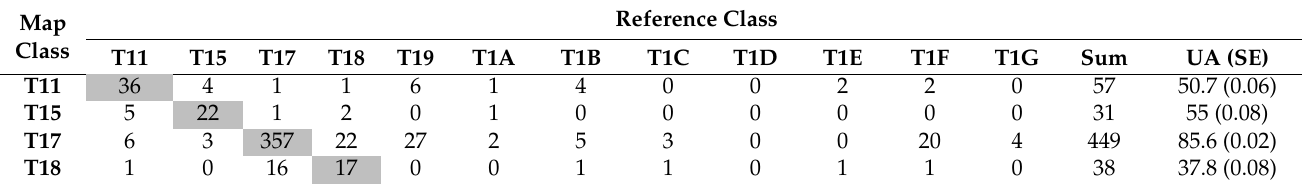
Table 5. Confusion matrix of RF result for the broadleaved deciduous forest habitat-type EUNIS III level classification. T11: temperate Salix and Populus riparian forest, T15: broadleaved swamp forest on non-acid peat, T17: Fagus forest on non-acid soils, T18: Fagus forest on acid soils, T19: temperate and submediterranean thermophilous deciduous forest, T1A: mediterranean thermophilous deciduous forest, T1B: acidophilous Quercus forest, T1C: temperate and boreal mountain Betula and Populus tremula forest on mineral soils, T1D: southern european mountain Betula and P. tremula forest on mineral soils, T1E: Carpinus and Quercus mesic deciduous forest, T1F: ravine forest, T1G: A. cordata forest. OA: Overall Accuracy, PA: Producer’s Accuracy, UA: User’s Accuracy, SE: Standard Error.